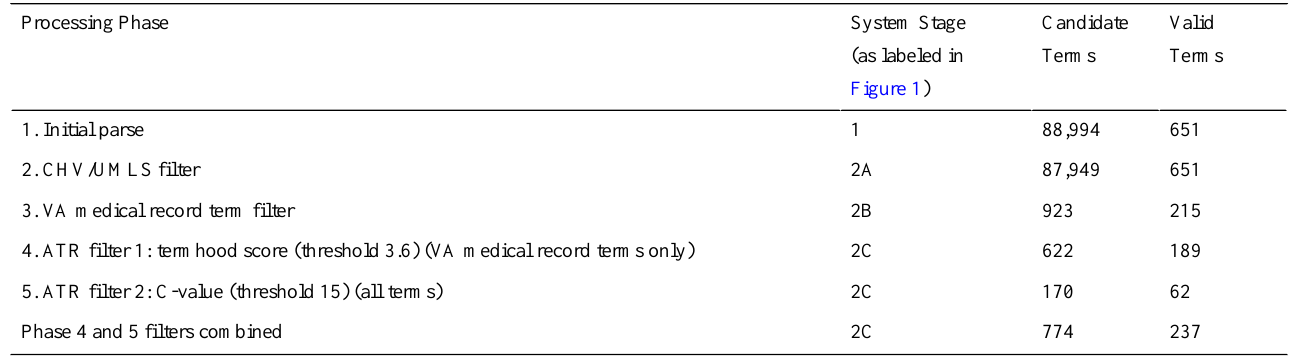
Table 1. Results at each stage of CAU processing